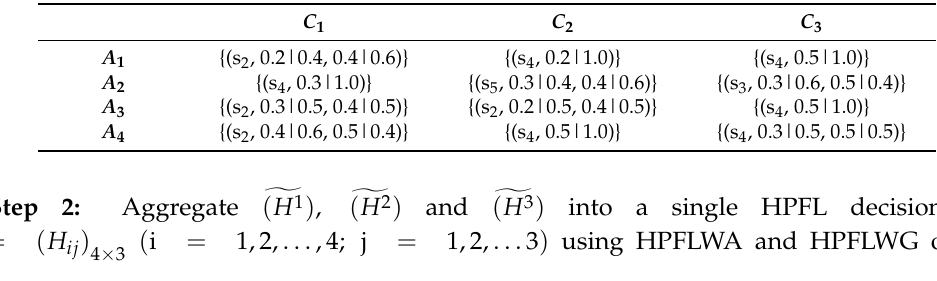
Table 3. HPFL decision matrix (cid:102) H 3 provided by D 3